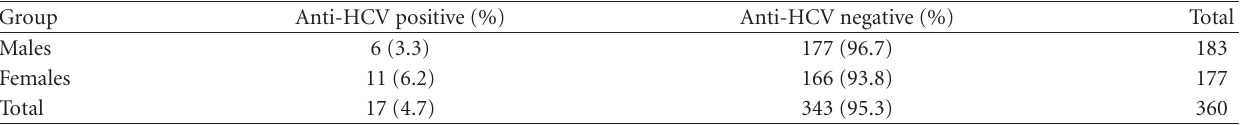
Table 1: Anti-HCV serostatus of patients.